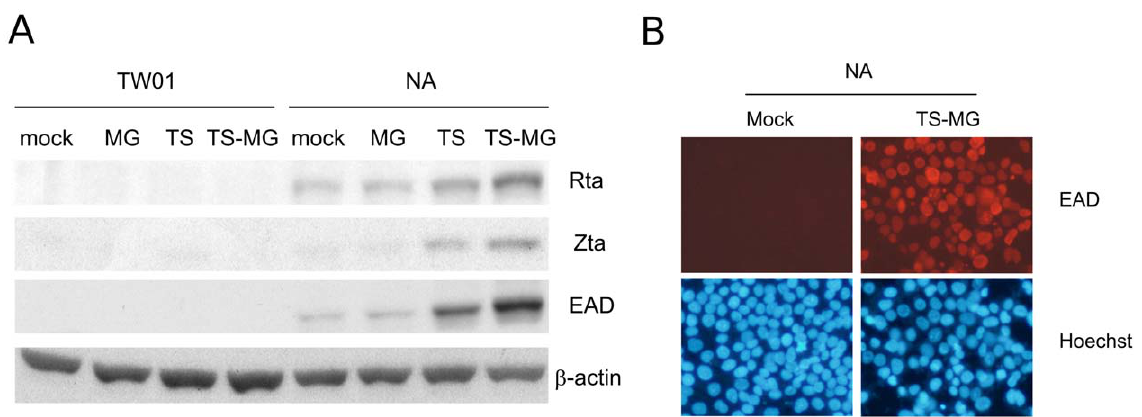
Figure 1. MNNG enhances TPA/SB-induced EBV reactivation. Cells were mock or treated with indicated chemicals. (A) Cell lysates were subjected to western blot analysis of EBV lytic protein Rta, Zta, and EAD. Reactivation of EBV was enhanced by co-treatment of MNNG and TPA/SB in NA cells, as determined by the expression level of lytic proteins. b -actin was used as a loading control. MG, TS and TS-MG indicate cells treated with MNNG, TPA/SB, and TPA/SB combined with MNNG, respectively. (B) Over 70% of NA cells were induced into EBV reactivation by the combination treatment of MNNG and TPA/SB, as determined by immunofluorescence assay of EAD. The nuclei of cells were stained with Hoechst 33258.